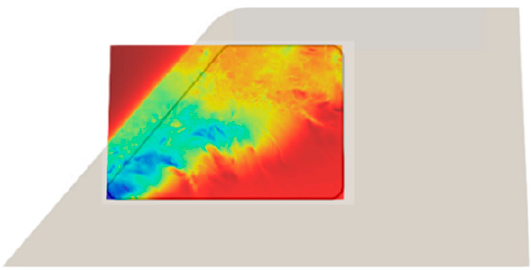
Figure 10. Virtual rectangular monitoring area for left side window. Table 3. Parameters of three-dimensional DFT for wall pressure fluctuation signal of side windows.